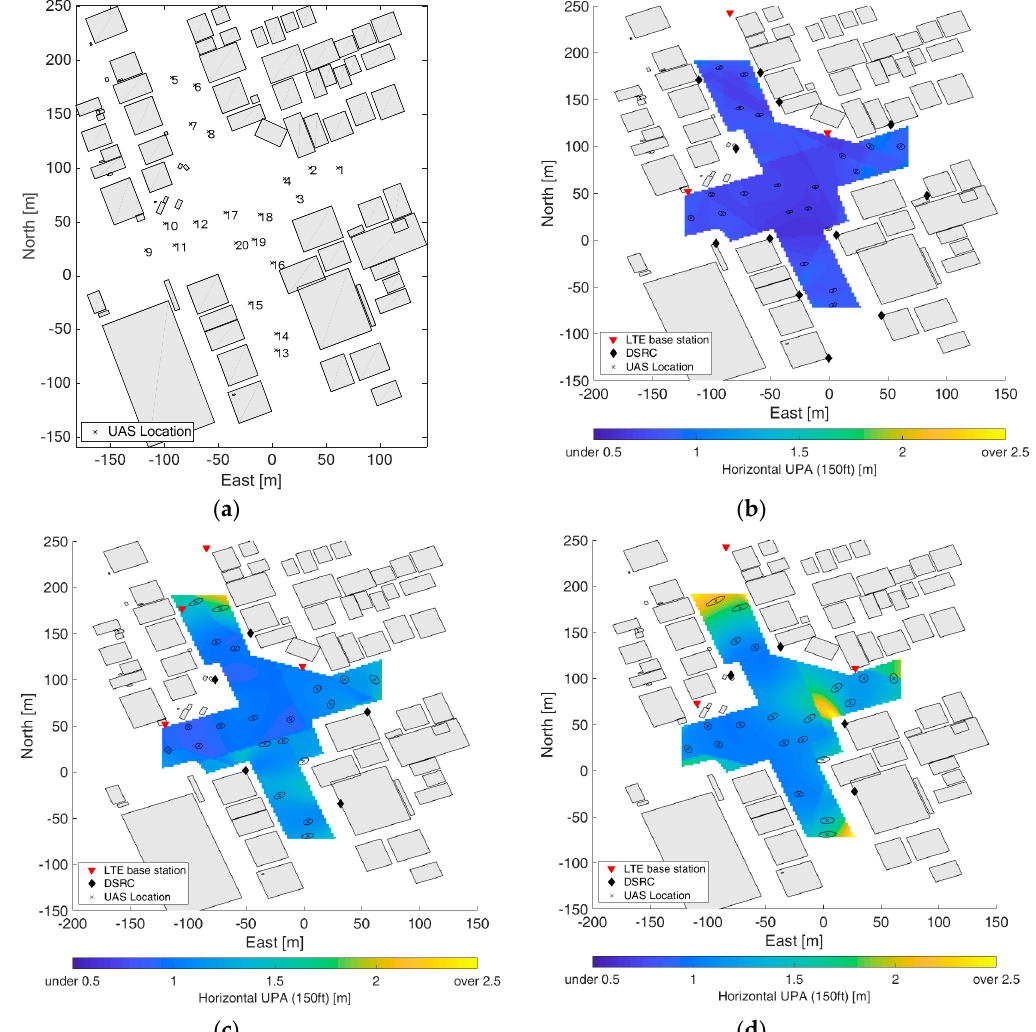
Figure 6. ( a ) Twenty UAS locations in the modeled environment. ( b – d ) Show user positioning accuracy (UPA) of the flight space and confidence ellipses of the 20 UAS in the optimized positioning network for 1, 2, and 3 m, respectively. As expected, the best user positioning accuracy is when the flight space is well surrounded by ranging sources.